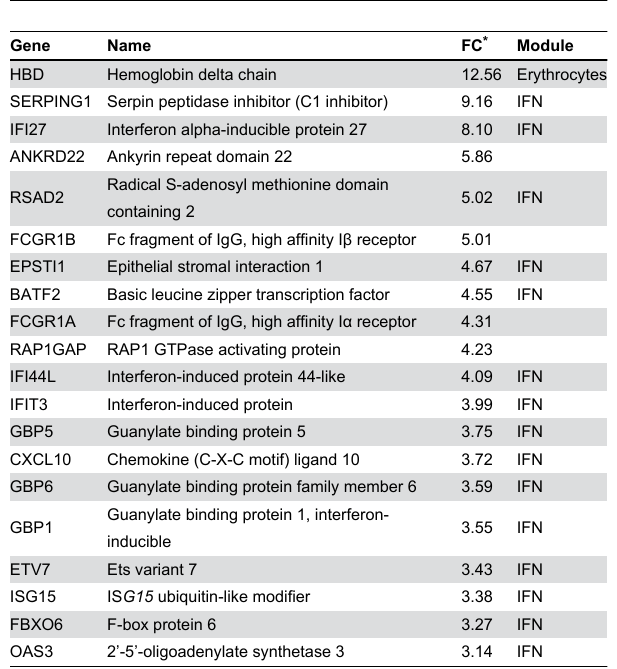
Table 4. Up-regulated genes: Healthy Controls vs. CVID without inflammatory complications.